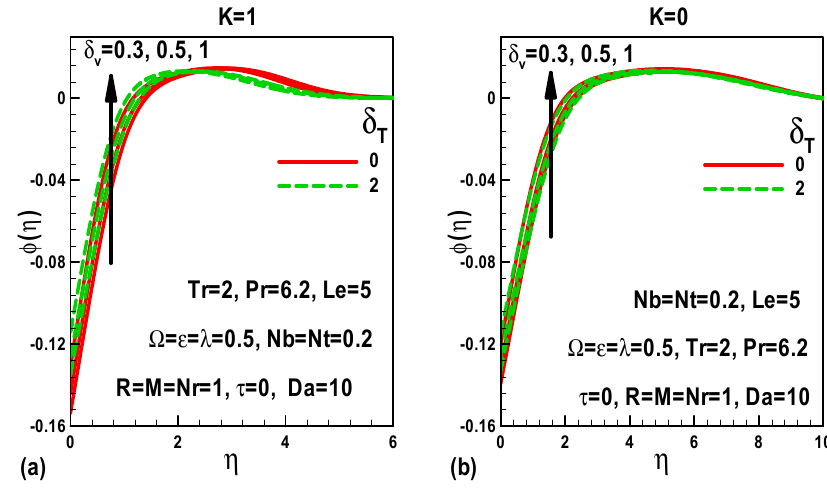
Figure 9. Effects of slip parameters on dimensionless velocity ( a ) with pressure gradient and ( b ) without pressure gradient.